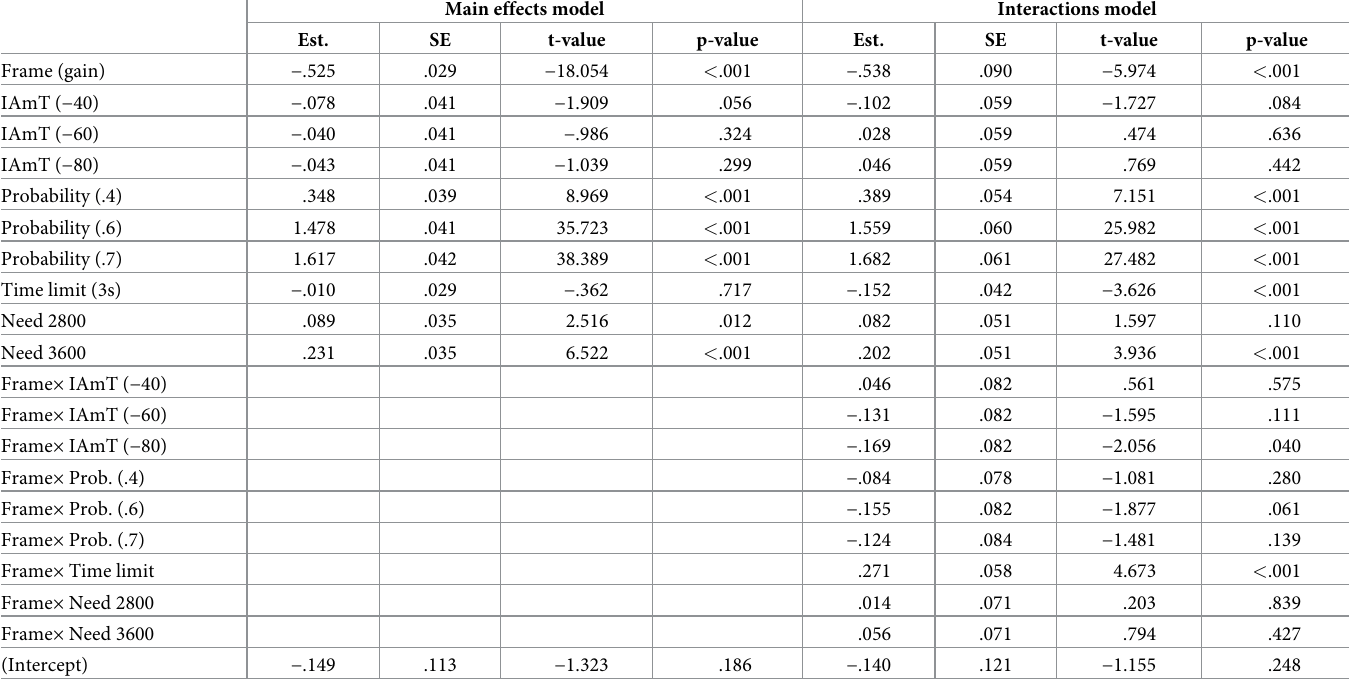
Table 1. Generalized linear mixed-models. Main effects model Interactions